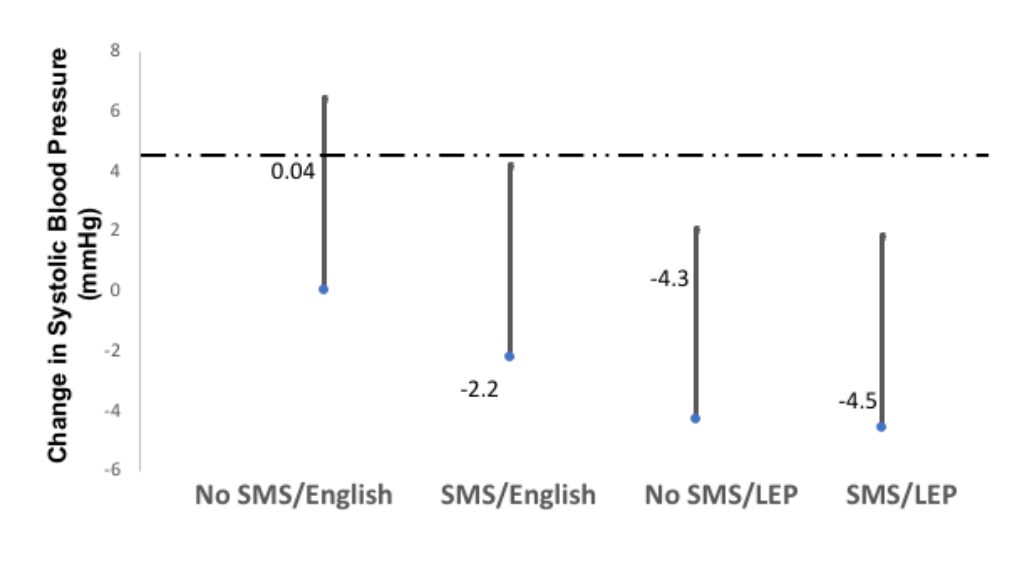
Figure 2. Estimated change in systolic blood pressure (95% CI) by intervention and English proficiency. LEP: limited English